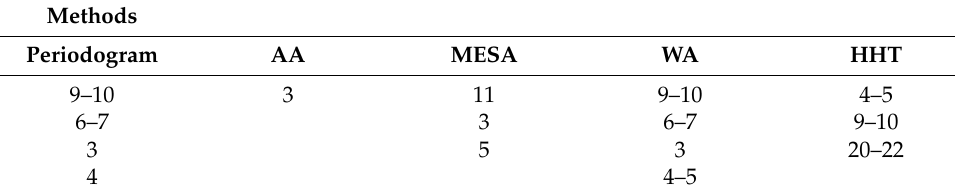
Table 8. The periods identified from annual series at Lijin station.